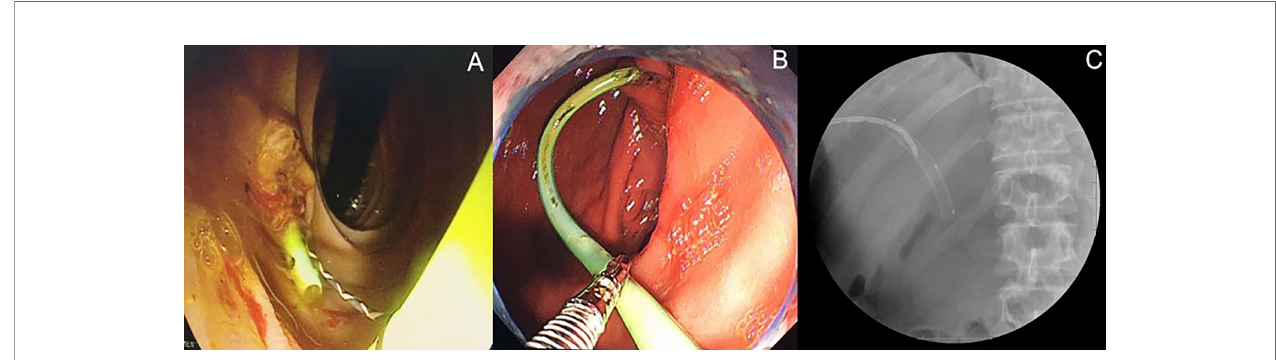
FIGURE 2 | Endoscopic retrograde biliary drainage (ERBD) stents were replaced by expandable fully-covered metallic stents via endoscopic retrograde cholangiography (ERC) at three months after operation. (A) ERBD stent in situ . (B) ERBD stent removed by endoscopic snare. (C) ERC after insertion of metallic stents into extrahepatic bile duct.